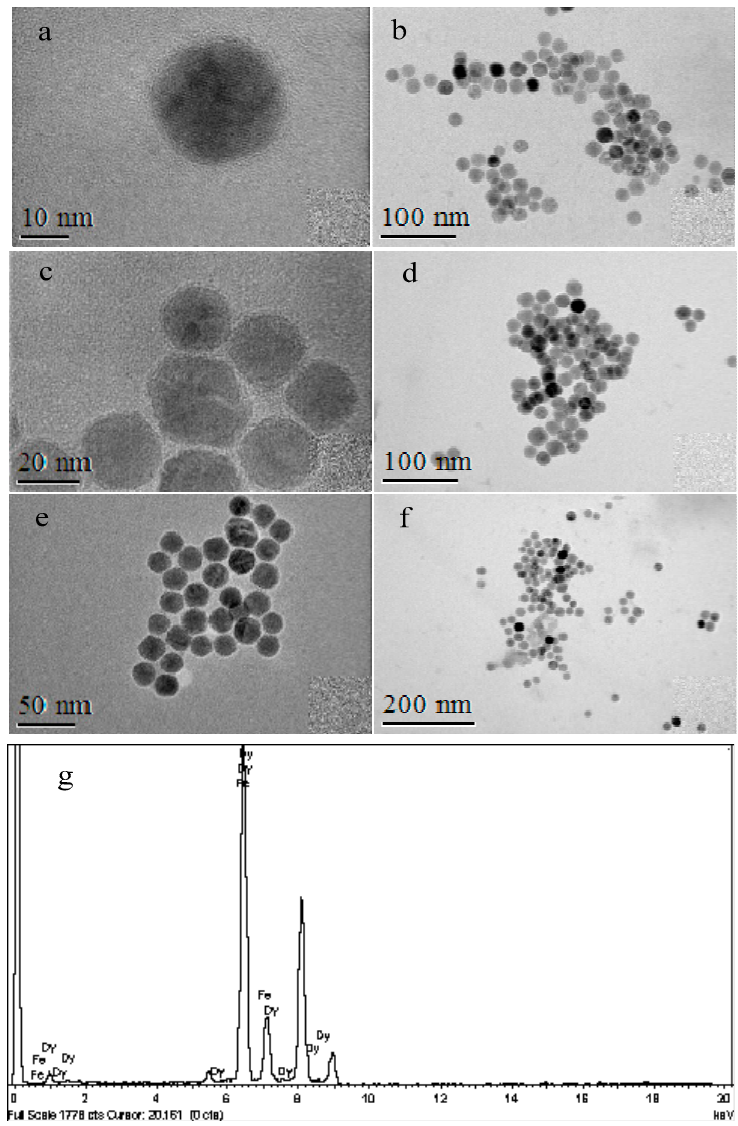
Figure 6. ( a – f ) TEM images of IO-NPs decorated with SYML-Dy2. ( g ) Energy-dispersive X-Ray spectra of NP with SYML-Dy2.